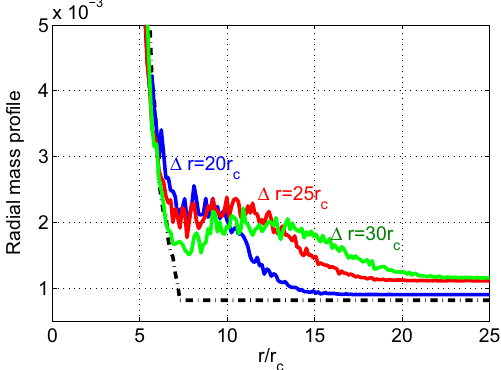
tive plots for intermediate ( (cid:5) r = 7 . 5 r c ) and late ( (cid:5) r = 15 r c ) post- collision separations, for weakly interacting DM ( solid lines ) and CDM ( dashed lines ), for k = 1 . 5 ( left ), k = 2 . 0 ( center ) and k = 4 . 0 ( right )